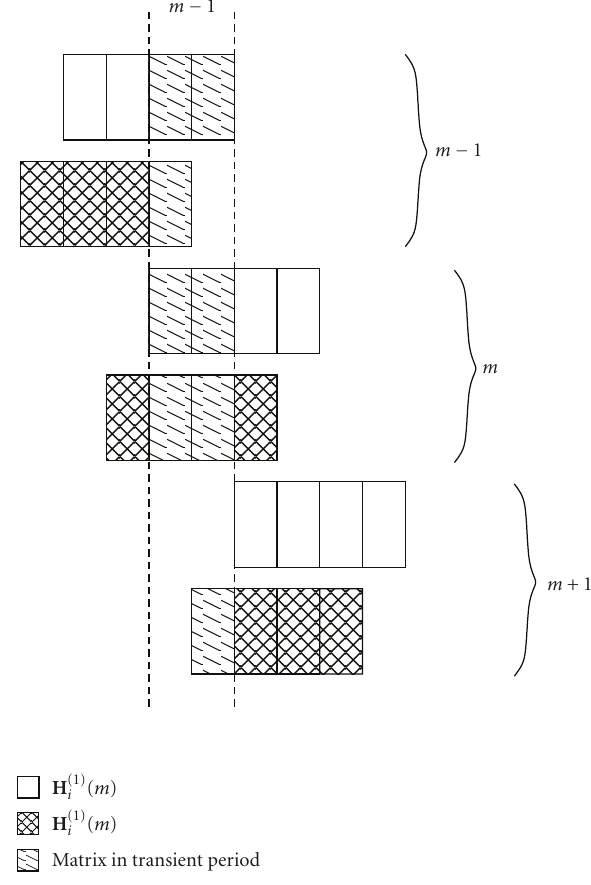
Figure 7: Graphical representation of the analysis matrix T a ( m ) around time point m